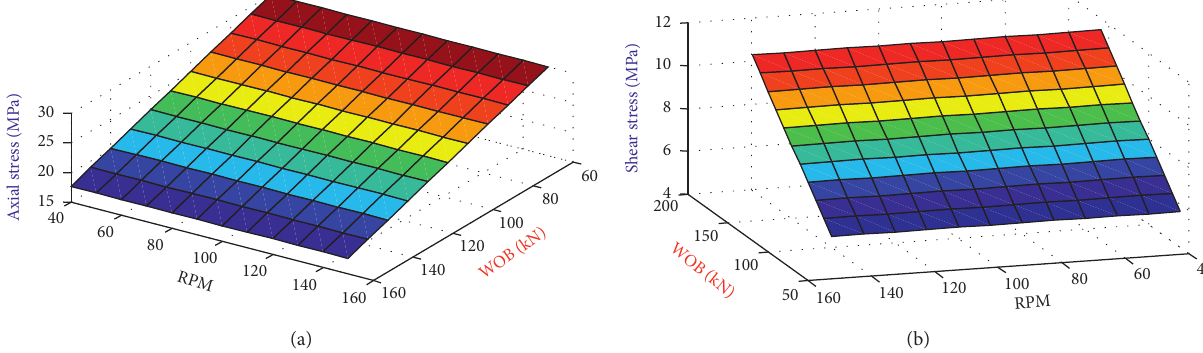
Figure 12: (a) Schematic diagram of axial stress change. (b) Schematic diagram of shear stress change (point B of example 2, WOB: 60–160kN and RPM: 40–150rpm).